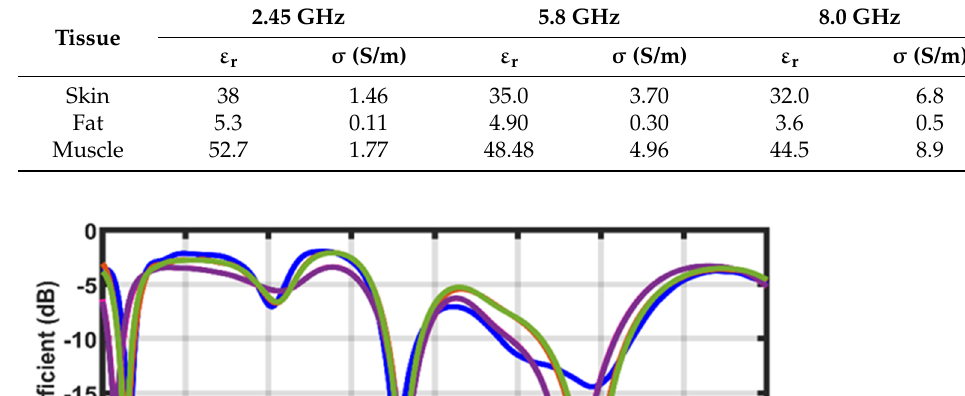
Table 3. Dielectric Properties of tissues at various frequencies.